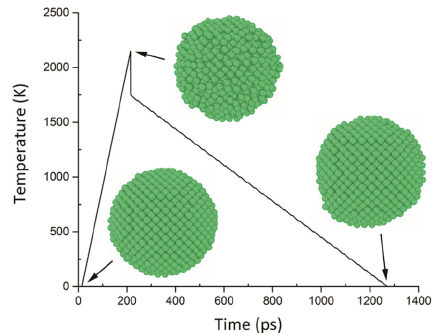
Figure 1. Plot of temperature changes for annealing Fe nanoparticle.